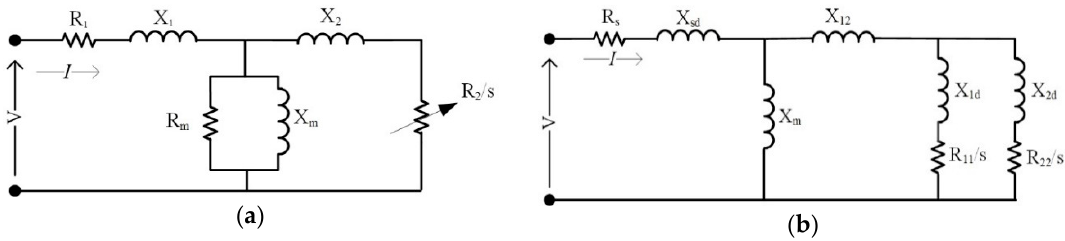
Figure 1. Basic IM models: ( a ) single-cage model; and ( b ) double-cage model.